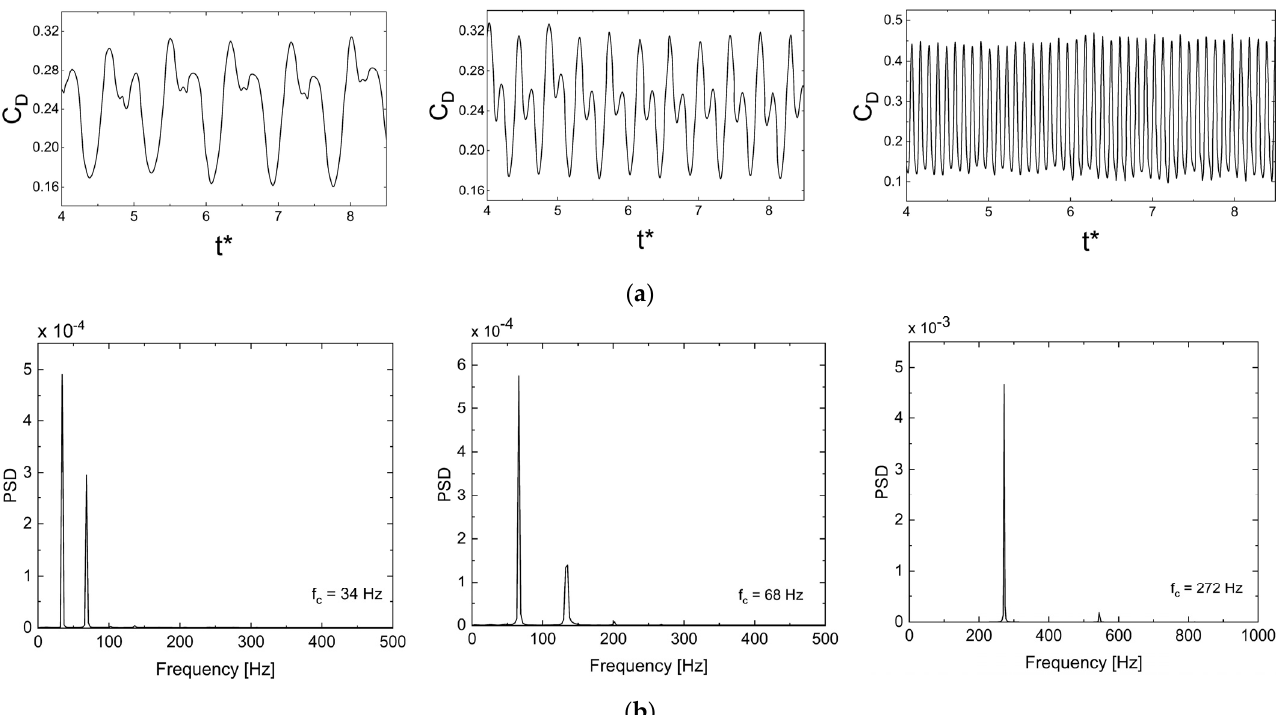
Figure 24. Spectral analysis of drag coefficient with a synthetic jet at different control frequencies. ( a ) C D signal; ( b ) PSD of C D .